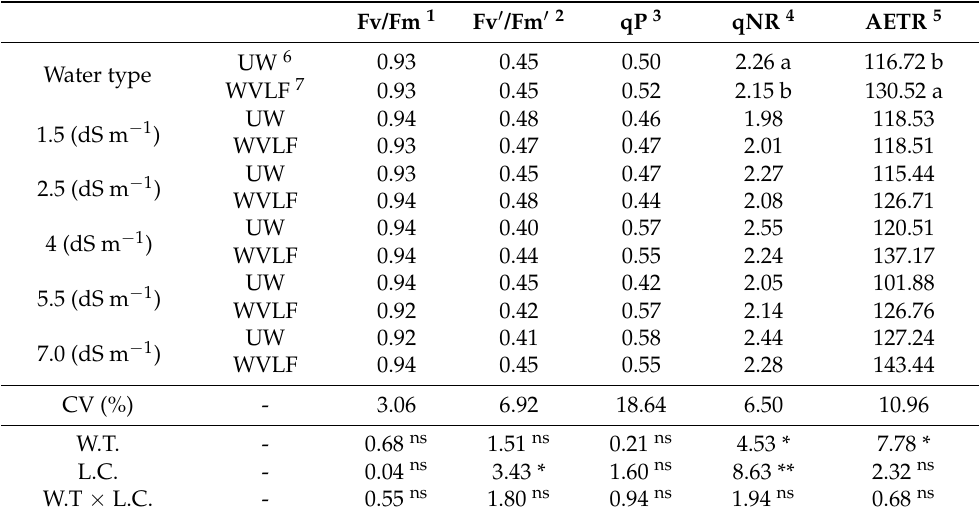
Table 2. Fluorescence of chlorophyll a of tomato crop subjected to different levels of fertigation and water types.